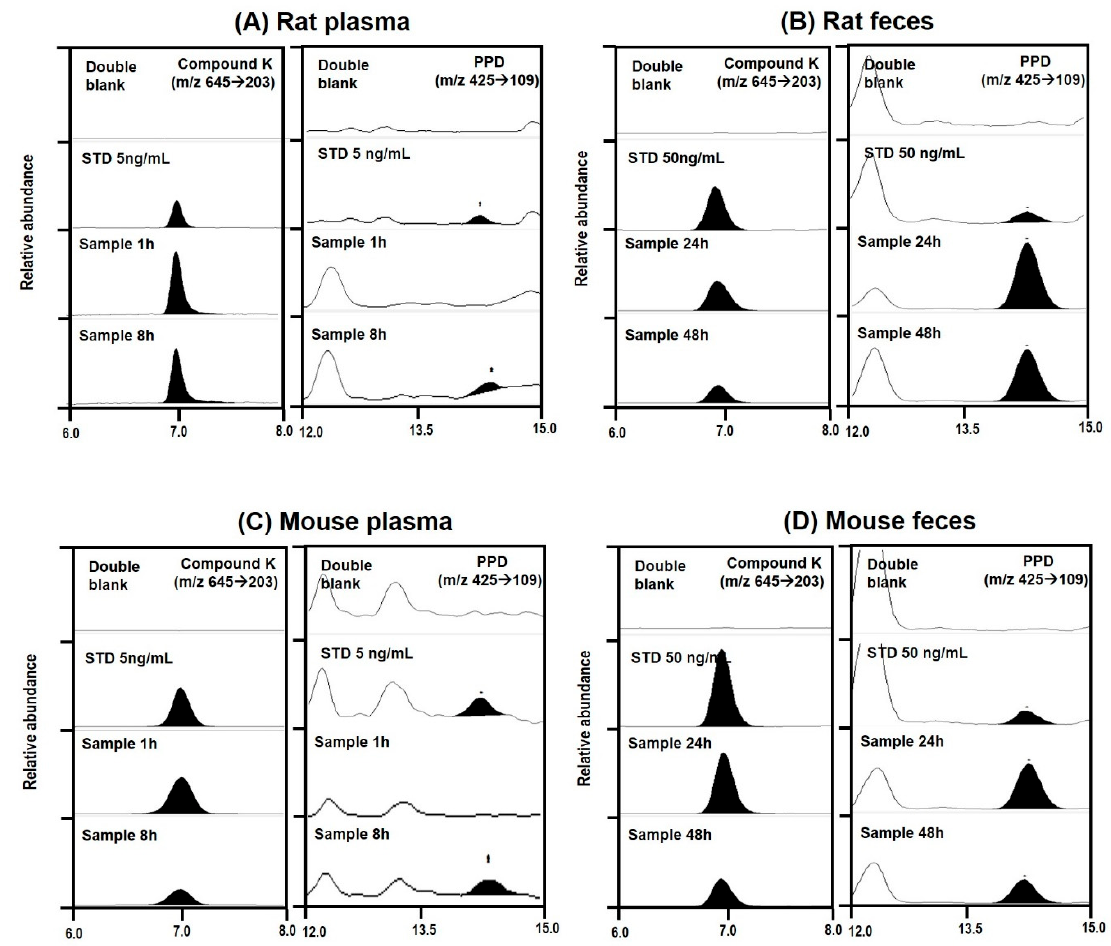
Figure 6. Representative multiple reaction monitoring chromatogram of compound K and PPD in plasma and feces samples collected from rats ( A , B ) and mice ( C , D ) following intravenous injection of compound K at a dose of 2 mg/kg.